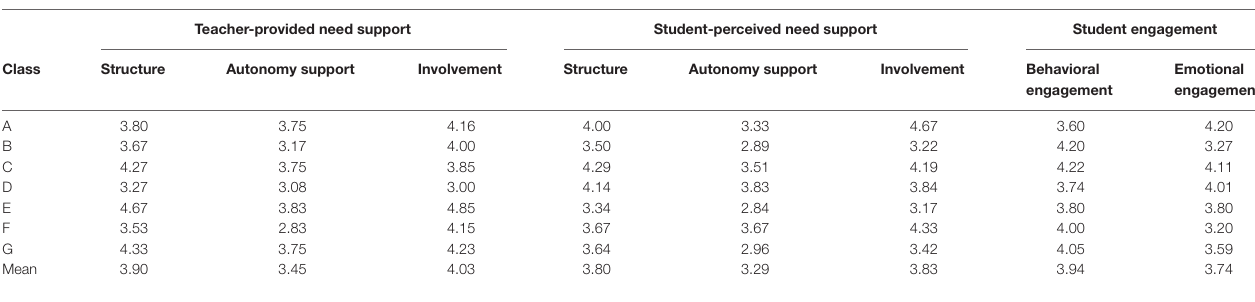
Table 3 | Results of the questionnaire. Teacher-provided need